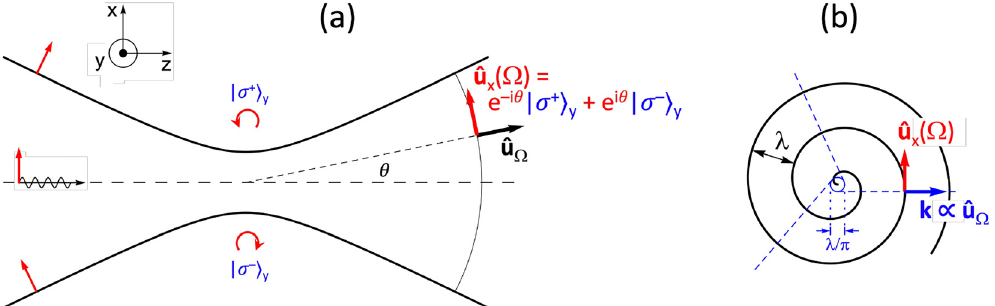
Figure 1: Examples of nonparaxial light fields with ‘intertwined’ SAM and OAM. (a) In the wings of a tight focus in an x -polarized beam the polarization is circular ( 𝜎 ± ) ( Ω ) ≡ ̂ u ( 𝜃,𝜙 ) is tilted linear which can be decomposed in two spiral waves with opposite handedness (e ∓ i 𝜃 ) and opposite polarization ̂ u x x . (b) In the plane of a rotating dipole, the polarization is in-plane linear, while the wavefront of the emitted light has a spiral polarization ( 𝜎 ± ) y shape. The light appears to originate from a location λ = 𝜆 ∕ 2 𝜋 away from the atom. For observers in different (in-plane) directions ̂ u Ω , the light appears to originate from a different point r = 𝜆 ̂ u Ω × ̂ y , on a circle with radius λ (solid). Three example viewing directions are indicated by dashed lines. The apparent origin displacement corresponds to an amount L = r × ℏ k ̂ u Ω = ℏ ̂ y of transverse OAM per photon, with ℏ k ̂ u Ω the linear momentum of a photon.